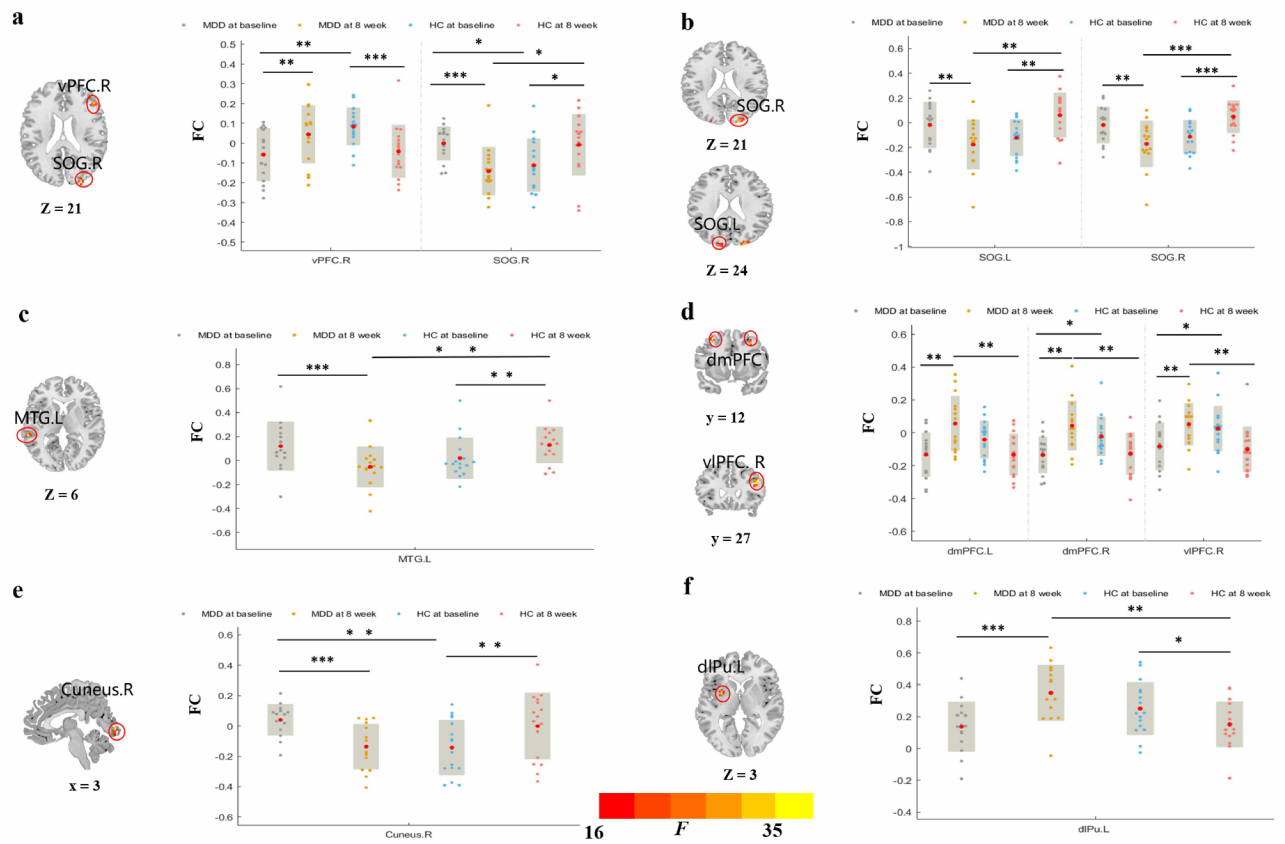
Figure 2. Group × Time interaction on the striatal subregions-based rsFC. ( a ) rsFC of significant Group × Time interaction on the left vCa-right vPFC/SOG and post hoc analysis. ( b ) rsFC of significant Group × Time interaction on the right GP-bilateral SOG and post hoc analysis. ( c ) rsFC of significant Group × Time interaction on the left NAc-left MTG and post hoc analysis. ( d ) rsFC of significant Group × Time interaction on the right NAc-bilateral dmPFC/right vlPFC and post hoc analysis. ( e ) rsFC of significant Group × Time interaction on the left dCa-right cuneus and post hoc analysis. ( f ) rsFC of significant Group × Time interaction on the right dCa-left dlPu and post hoc analysis.vCa, ventral caudate; vPFC, ventral prefrontal cortex; SOG, superior occipital gyrus; GP, globus pallidus; NAc, nucleus accumbens; MTG, middle temporal gyrus; dCa, dorsal caudate; dlPu, dorsolateral putamen; dmPFC, dorsal medial prefrontal cortex; vlPFC, ventrolateral prefrontal cortex. * p < 0.05, ** p < 0.01, *** p < 0.001. F , ANOVA statistical value. The bar charts show within- and between-group differences in striatum rsFC. L, Left. R,